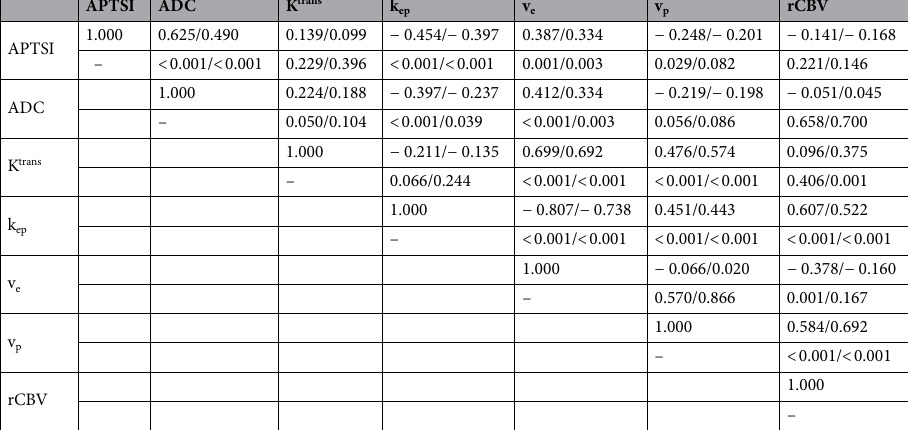
Table 2. Correlations between quantitative MR imaging parameters. In each cell, numbers in upper and lower indicate Spearman’s correlation coefficients (observer 1/observer 2) and corresponding p values (observer 1/ observer 2), respectively.